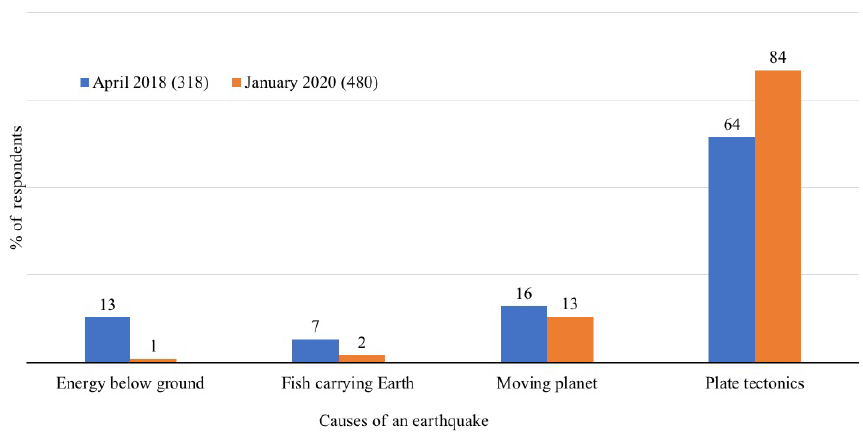
Figure 5. Student opinions on what causes earthquakes (Q1), before and after the initiation of our education program. ( χ 2 = 78 . 15, p value = < 0 . 00001; the change is